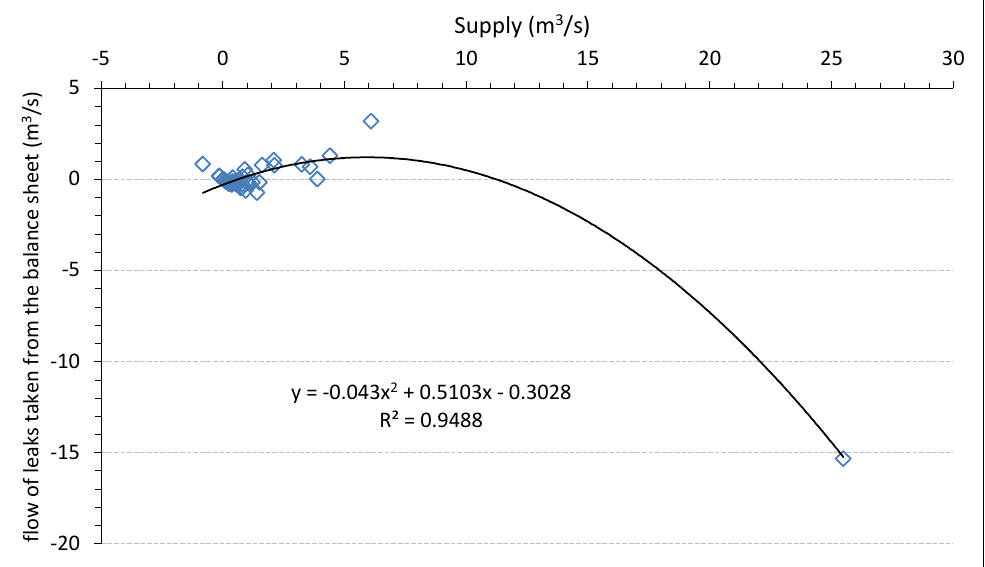
Figure 34. Variation in the leakage rate deducted from the hydraulic balance as a function of the entering flow of Hammam Grouz dam, Algeria Negative flow values show that the inflow per tributary deducted from the daily water balance of the dam is greater than the inflow recorded at the hydrometric